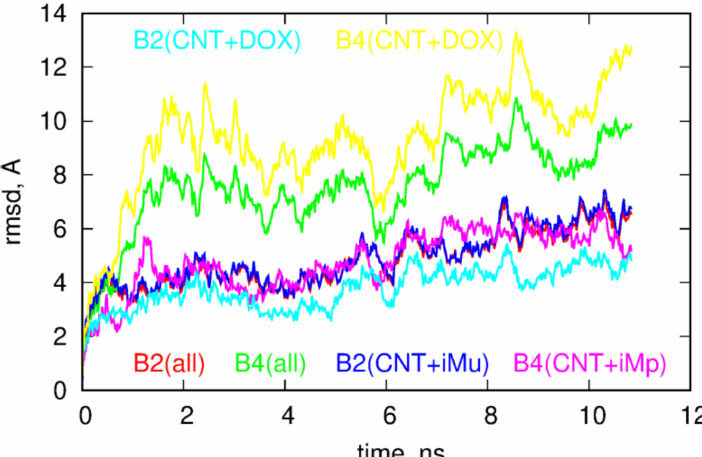
Figure 4. Plots of root of mean squared displacements, RMSD, as a function of time for systems from Figure 3. The label ‘all’ means that all atoms were taken into account in the computation of the RMSD, ‘CNT + iMu / p’ means that atoms belonging to DOX molecules were not accounted for in the computation and ‘CNT + DOX’ means that only atoms belonging to CNT and DOX were accounted for in the computation of the